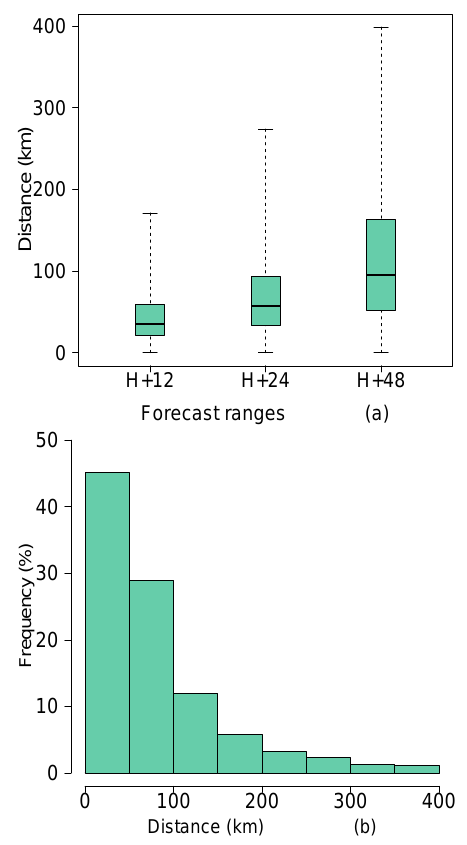
Fig. 2. Frequency distribution of distance (km) between forecast and analysed centres, (a) for three forecast ranges and (b) for all forecast ranges.